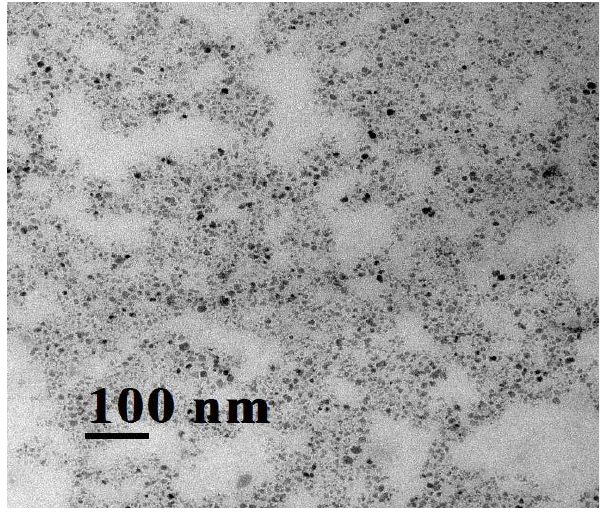
Figure 1. TEM image of Mn 0 . 75 Zn 0 . 25 Fe 2 O 4 (MZF) ferrofluid.